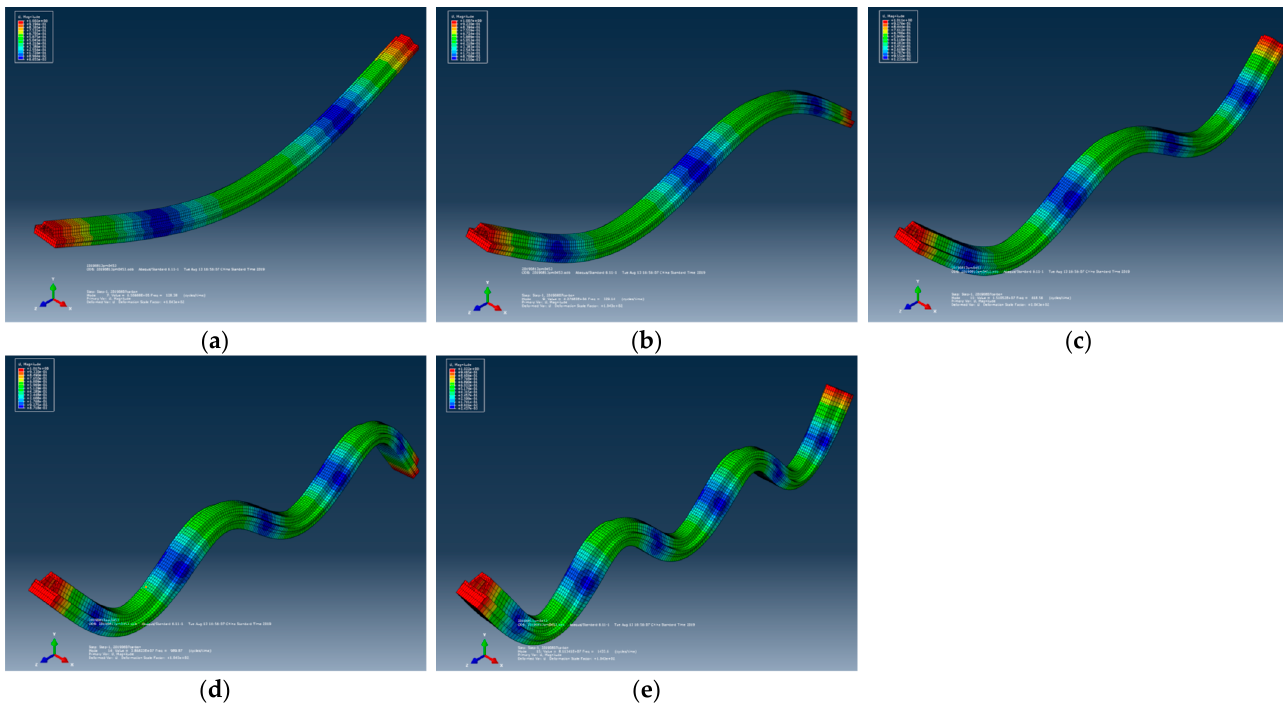
Figure 11. Modal frequencies and mode shapes of a pantograph frame. ( a ) First mode, 2.0 Hz. ( b )